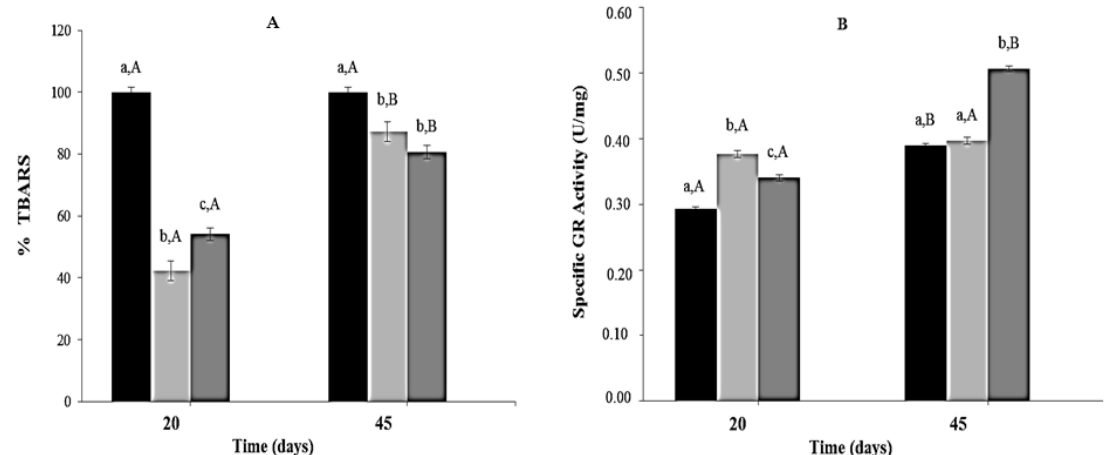
Figure 4. Lipid peroxidation (TBARS) and Glutathione Reductase (GR) activity in plasma of ad libitum fed and caloric restricted mice: ( A ) TBARS levels and ( B ) GR activity of: ( (cid:4) ) ALF Group: ad libitum fed; ( (cid:4) ) CR Group: caloric restriction; and ( (cid:4) ) CR-Lf Group: caloric restriction plus L. fermentum CRL1446.Bars represent the mean ˘ SEM, n = 12 per group. Data with different lowercase letters (a–c) at the same period of treatment and data with different uppercase letters (A,B) in the same group are significantly different ( p < 0.05) according to ANOVA statistical